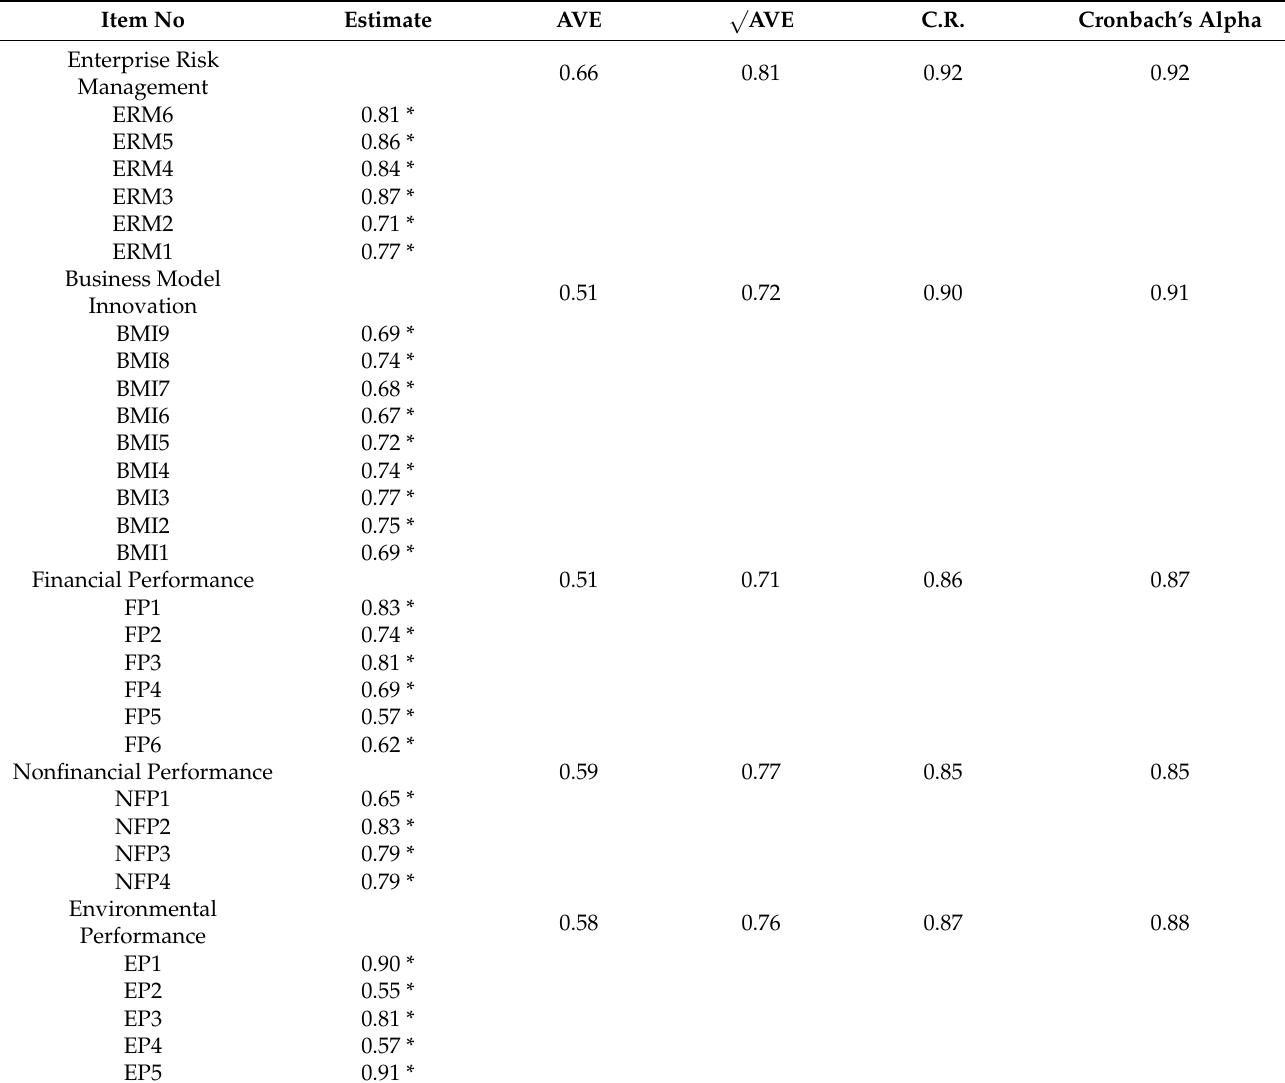
Table 3. Validity and